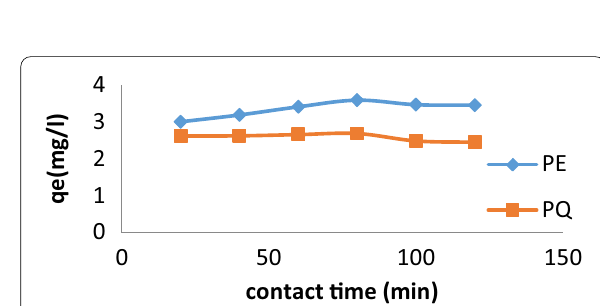
Fig. 4 Effect of time on adsorption of PE and PQ (adsorption conditions: concentration of PE and PQ T 25 °C, volume of solution =